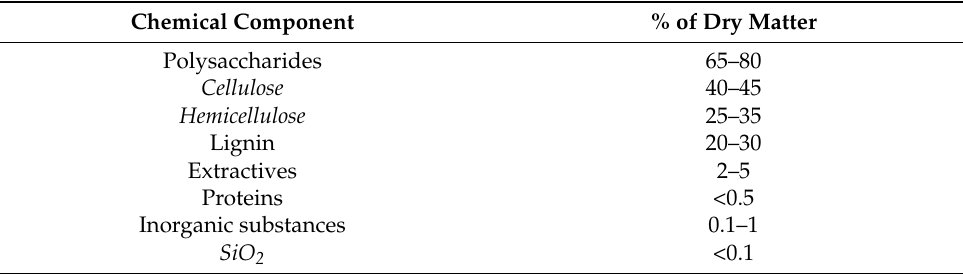
Figure 1. Schematic structure of ( a ) cellulose, ( b ) hemicellulose and ( c ) lignin. Table 1. Typical chemical components of wood [4].